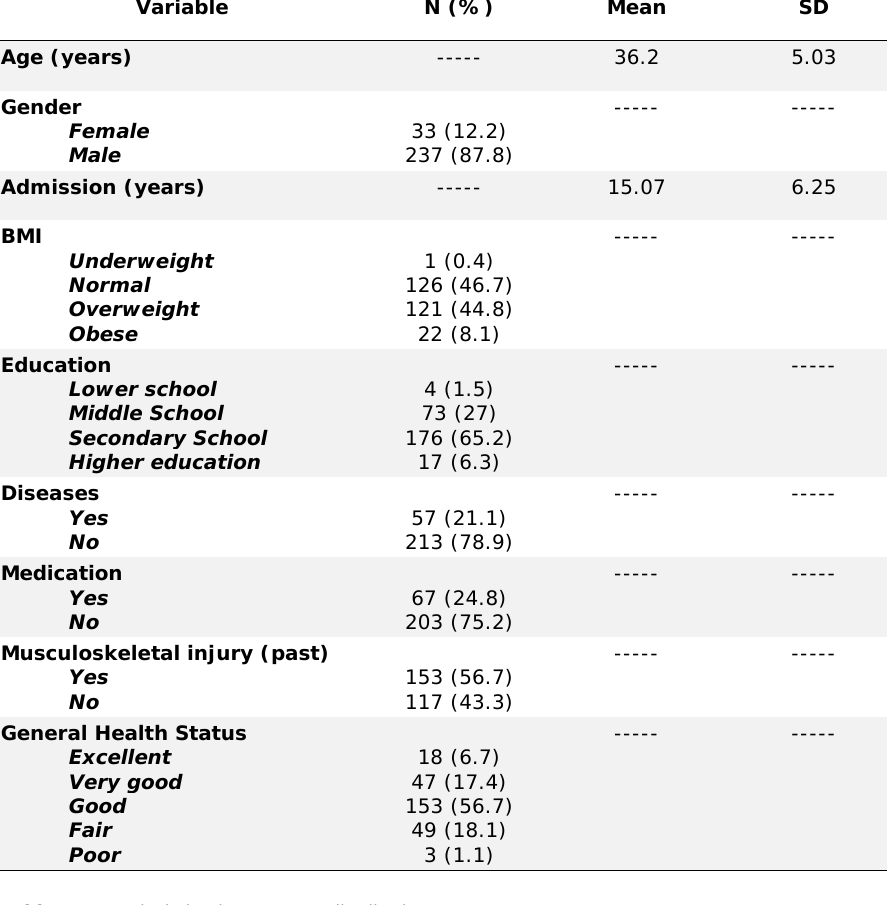
Table 1. Demographic, individual and health characteristics.